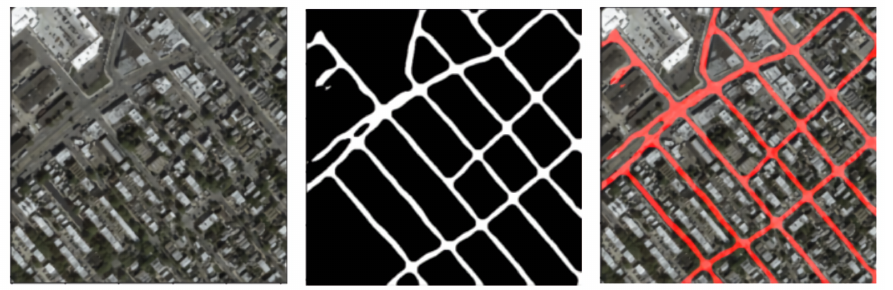
Figure 13. Another sample prediction on Pix2Pix using the trained model, which is post-processed and overlaid on the original image.(Left to Right) Satellite image, road mask, overlaid road